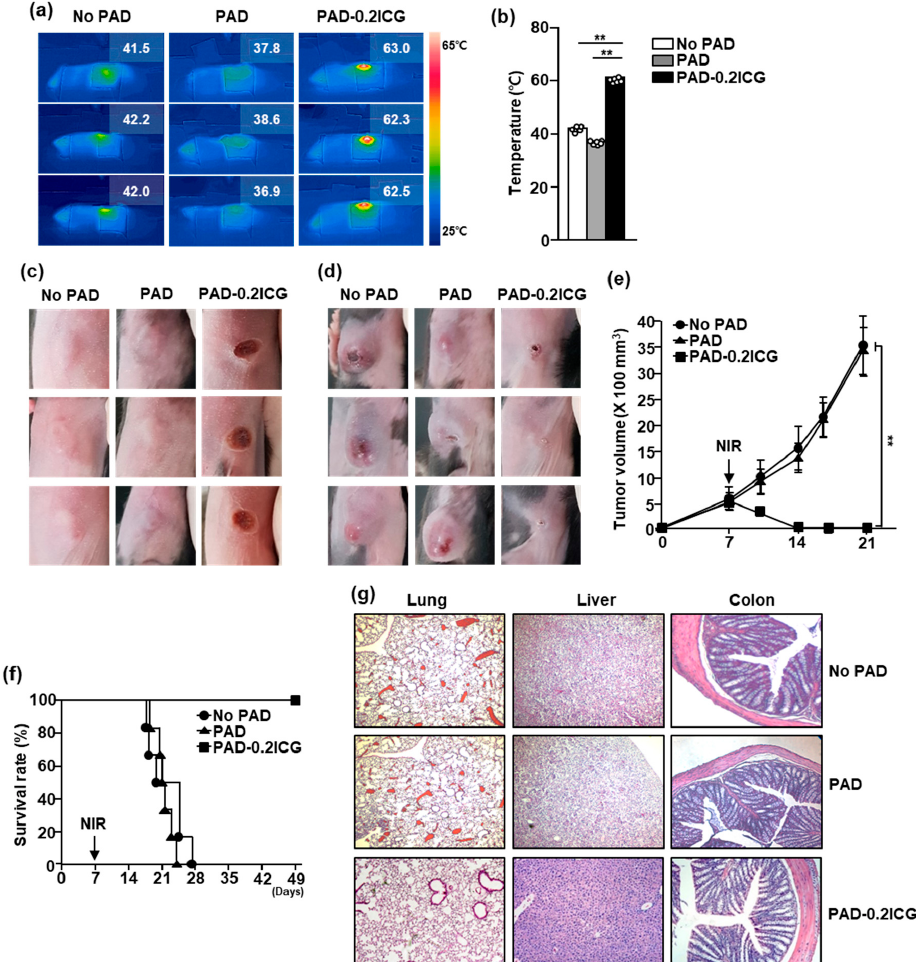
Figure 4. In vivo anti-melanoma therapeutic effect of PAD-ICG hydrogel using photothermal therapy. C57BL/6 mice were subcutaneously ( s.c. ) inoculated with 1 × 10 6 B16 cells: ( a ) NIR temperature camera imaging corresponding to the temperature distribution of PAD hydrogel loaded with 0.2 mg/mL of ICG. The temperature changes of pure PAD and PAD-ICG after 808 nm laser irradiation with 1 W / cm 2 for 5 min are shown; ( b ) the average temperature of pure PAD and PAD-ICG after irradiation at 1 W / cm 2 for 5 min. B16 tumor masses on day 10 ( c ) and on day 17 ( d ) after B16 tumor inoculation are shown; ( e ) the B16 tumor growth curves are shown; ( f ) on day 21 after tumor injection, the mice were sacrificed and the lung, liver and colon were harvested and the tissues stained with hematoxylin and eosin (H&E); and ( g ) the survival rates of mice were shown. Data are representative or show the average of six independent samples (two independent experiments performed with n = 3 / group). Significance was determined by log-rank test, ** p < 0.01 ( n =